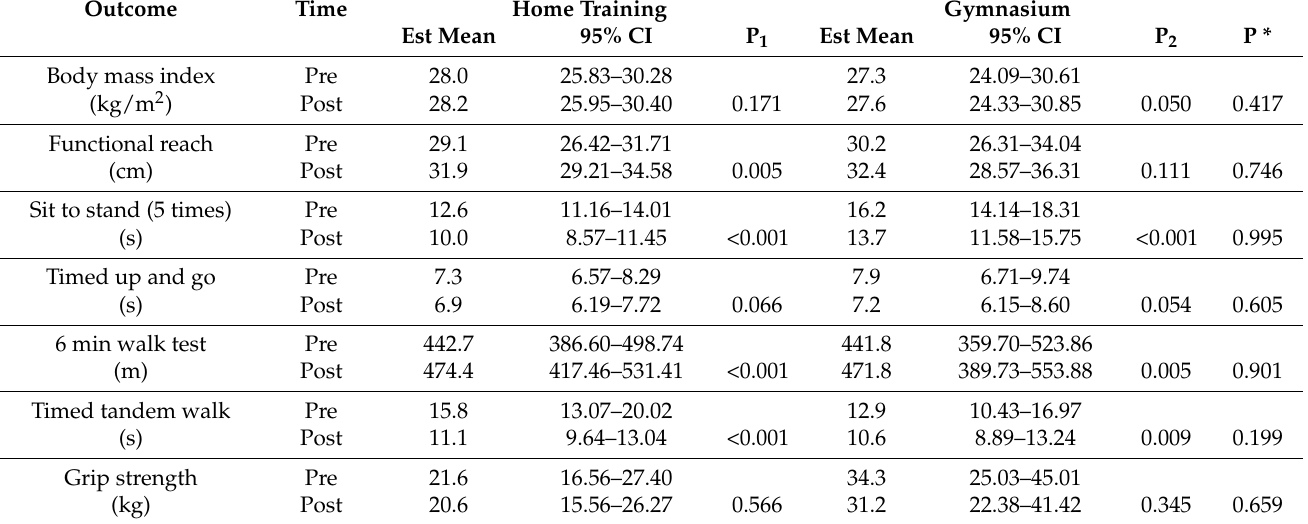
Table 2. Pre and post outcomes by